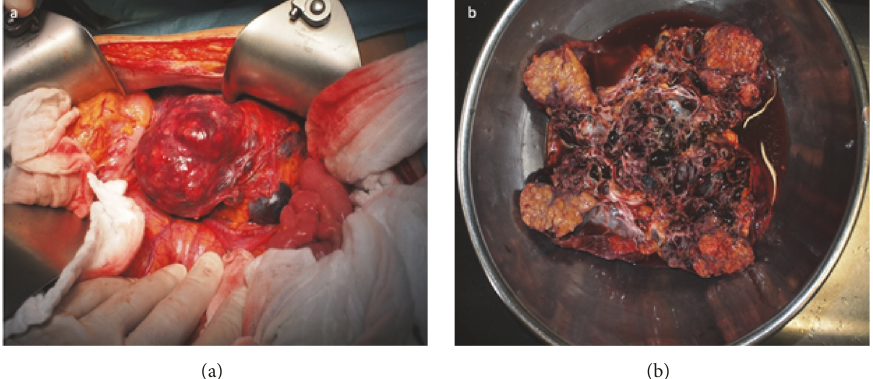
Figure 3: Periprocedural finding. (a) Embolised right kidney angiomyolipoma. (b) Explanted polycystic